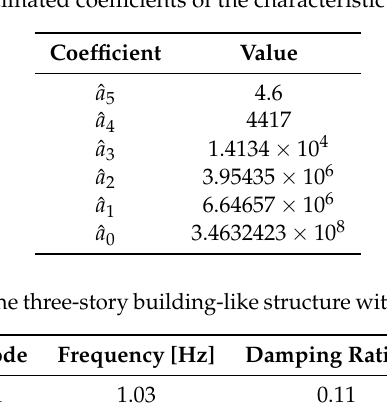
Table 3. Estimated coefficients of the characteristic polynomial.